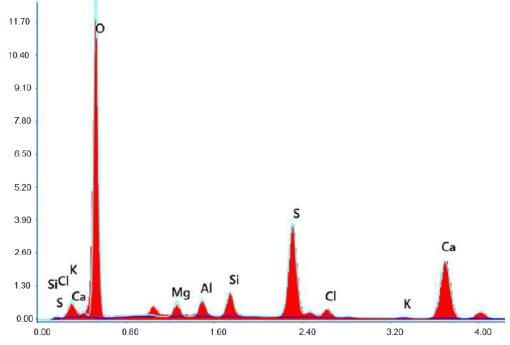
Figure 19. X-ray microanalysis (EDS) in point 1 from Figure 18.